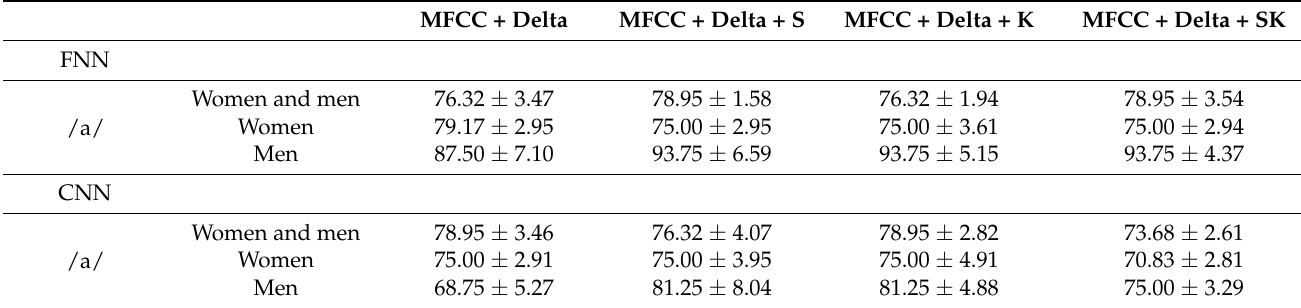
Table 5. Classification results obtained by MFCC delta, skewness, and kurtosis parameters and the two different deep learning methods.